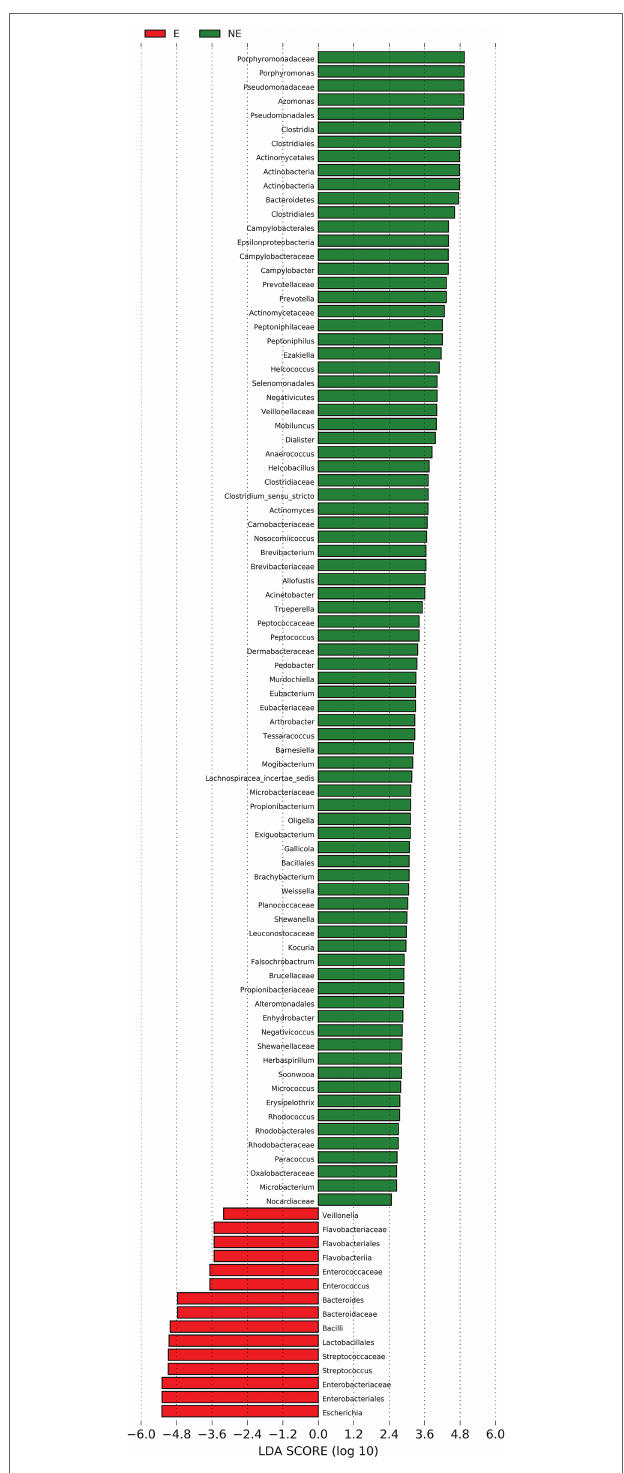
FIGURE 6 | Linear discriminant analysis (LDA) demonstrated distinct bacterial genera enriched in the E group and the NE group. The graph shows the LDA scores obtained from linear regression analysis of the significant microorganism groups in the two groups. When the default LDA value is more than 2 and the p value is less than 0.05, the result corresponds to a differential